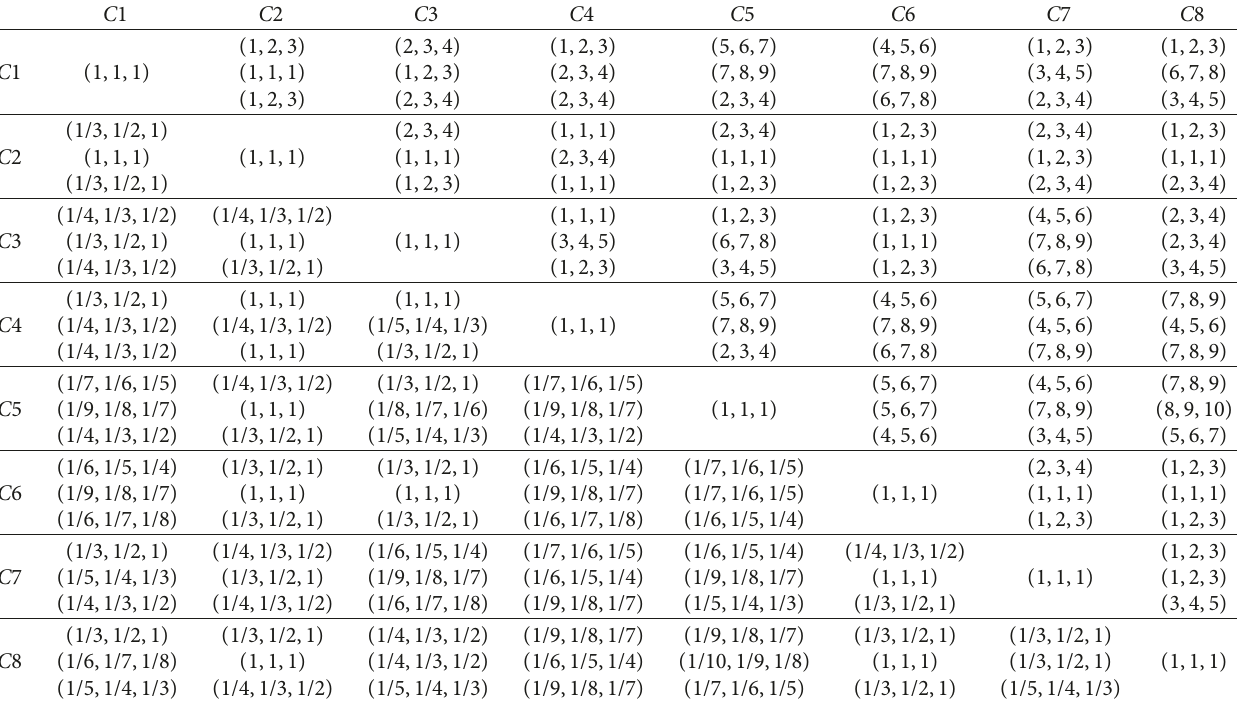
Table 6: Fuzzy dimension comparison